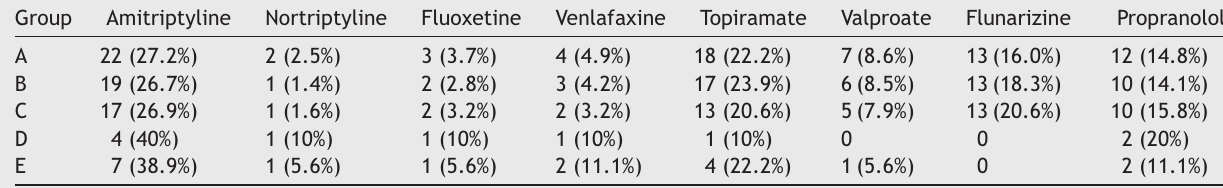
Distribution of drugs used for vestibular migraine prophylaxis according to the group.